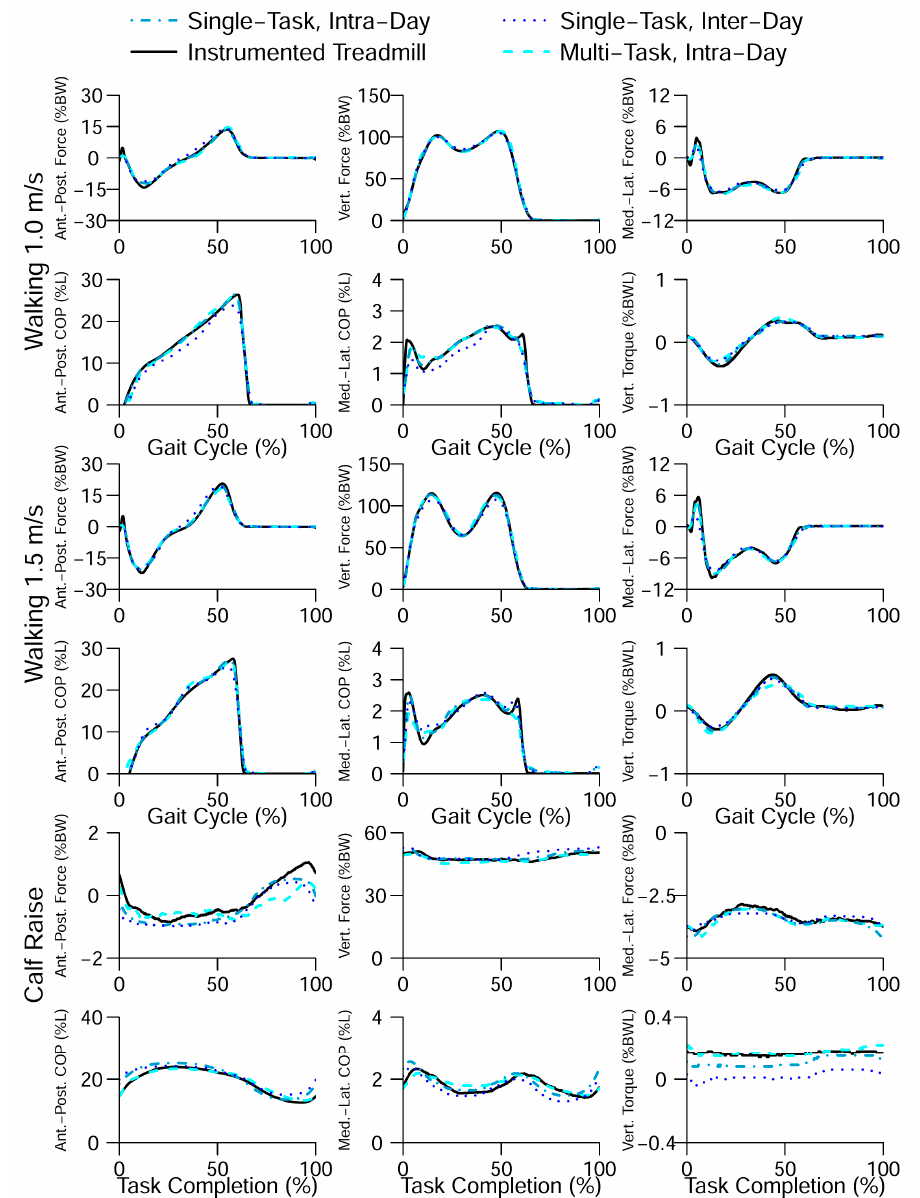
Figure 16. Comparison of the estimated tri-axial (cid:1833)(cid:1844)(cid:1832)((cid:1872)) and (cid:1833)(cid:1844)(cid:1839)((cid:1872)) signals for the method/system proposed by Jacobs and Ferris